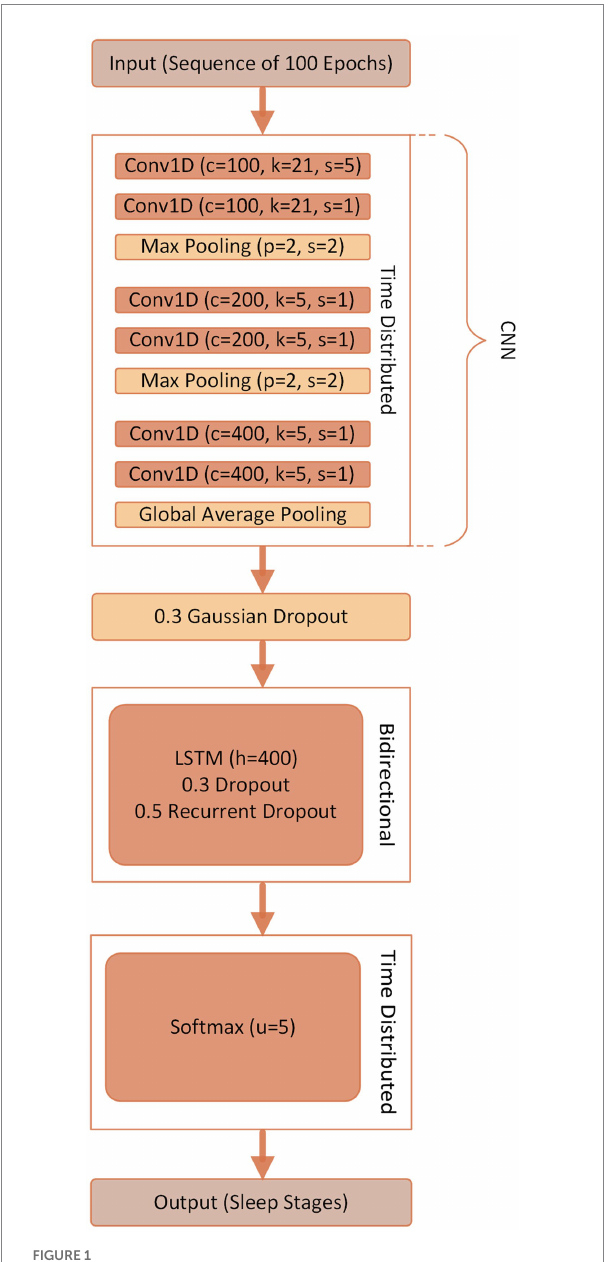
FIGURE 1 Illustration of the combined convolutional neural network (CNN) and long short-term memory (LSTM) network architecture. The parameters of the 1D convolution layers (Conv1D) are provided as (c = number of convolutional filters, k = kernel size, s = stride size). For the max pooling, the parameters are given as (p = pool size, s = stride size). LSTM and the softmax dense layer have the number of units as the parameter (i.e., h = number of hidden/output units in LSTM and u = number of nodes in dense layer). The dropout layers were active only during the training phase. A sequence of softmax values was generated by the model indicating the probabilities of possible sleep stages for every epoch. The sleep stage with the highest softmax value was estimated as the corresponding sleep stage of that